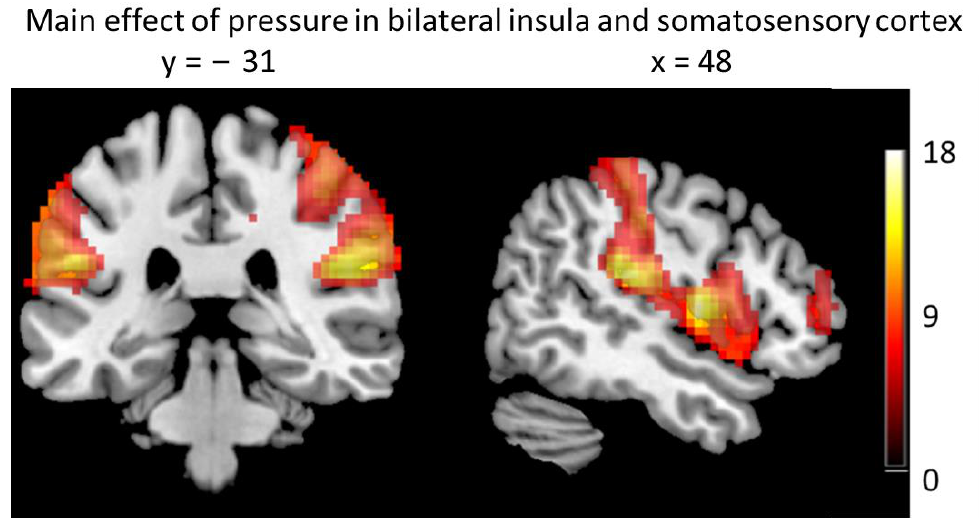
Figure 4. Main effect of pressure stimulus (high and low combined), thresholded at p = 0.05, FWE- corrected at the whole brain level, cluster-size > 50.